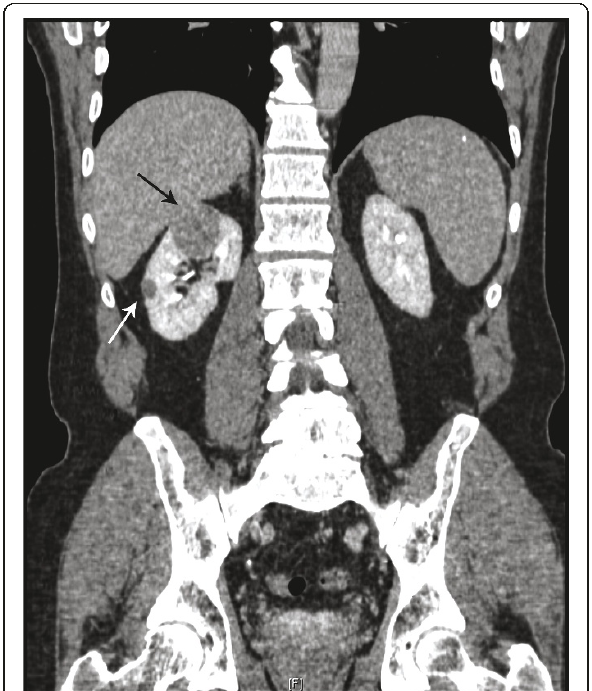
Figure 1 Imaging, Computed tomography (CT) showed the presence of two incidental well-circumscribed masses with similar density in the right kidney . The larger lesion was solid and enhancing and measured 3.5 cm; it was located in the upper pole and approached but did not extend into the renal sinus (black arrow). The smaller lesion measured 1.2 cm and was located along the mid lateral aspect of the kidney (white arrow). The contralateral kidney was